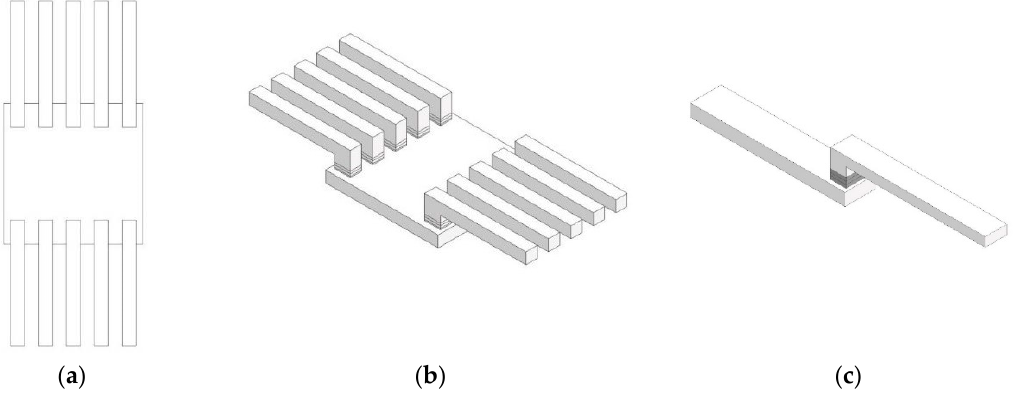
Figure 2. Geometry of sintered test specimen on basic substrate plate. ( a ) Top view. ( b ) Perspective view. After sintering, the hybrid print plate is separated into ten single test specimens. ( c ) Reference sample as benchmark object (binding layers 5 × 7 mm 2 grey).